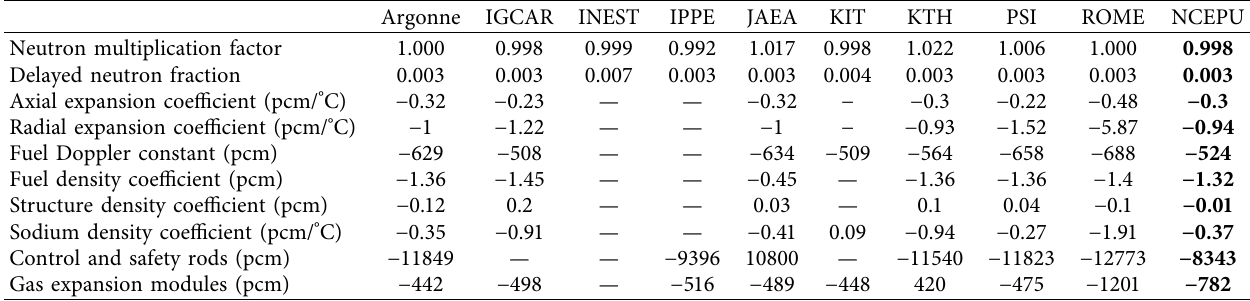
Table 6: Main results of FFTF LOFWOS test #13 neutronics benchmark analysis